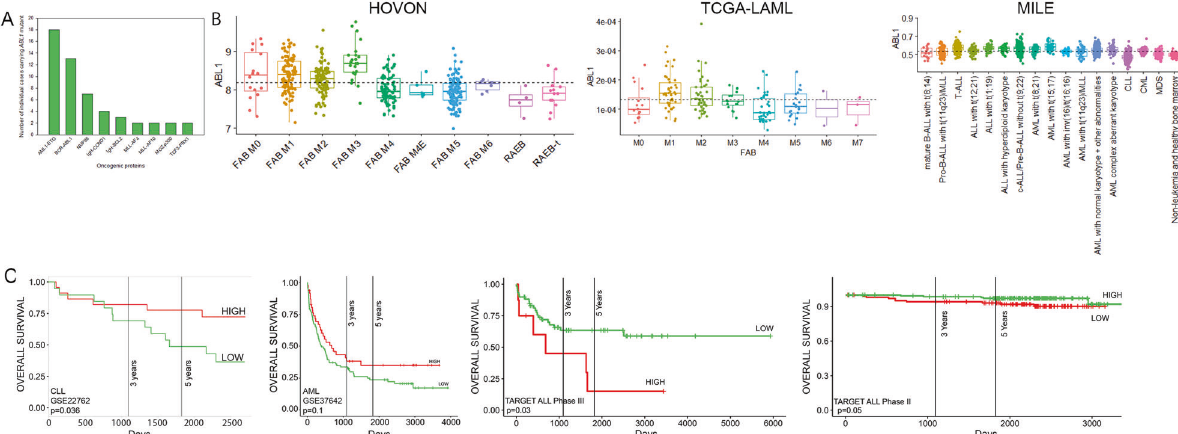
Fig. 1 ABL1 as a prognostic factor. A Chromosomal aberrations detected in leukemias carrying del(9q34) or deletions encompassing this region resulting in loss of ABL1 in CGAP Mitelman database (https://mitelmandatabase.isb-cgc.org/). B Normalized ABL1 expression from HOVON, TCGA-LAML, and MILE (left to right) datasets. HOVON and MILE datasets were sourced from Affymetrix microarrays and normalized using the RMA method, while the TCGA-LAML dataset is is a set of rlog-normalized RNA-seq expression values. C Kaplan-Meier estimates of the overall survival of patients with indicated leukemias based on ABL1 expression levels. HIGH and LOW cohorts in AML GSE22762 were divided at mean of the gene expression. Cutoffs for the AML dataset GSE37642 and the ALL datasets from TARGET ALL phases II and III (9.81, 4.05, and 10.88 of the RMA-normalized Affymetrix ABL1 expression values, respectively) were determined using the maxstat package in R, an extension of the Hothorn and Lausen (2002) method to select maximally selected cut points. p values were calculated from the log-rank